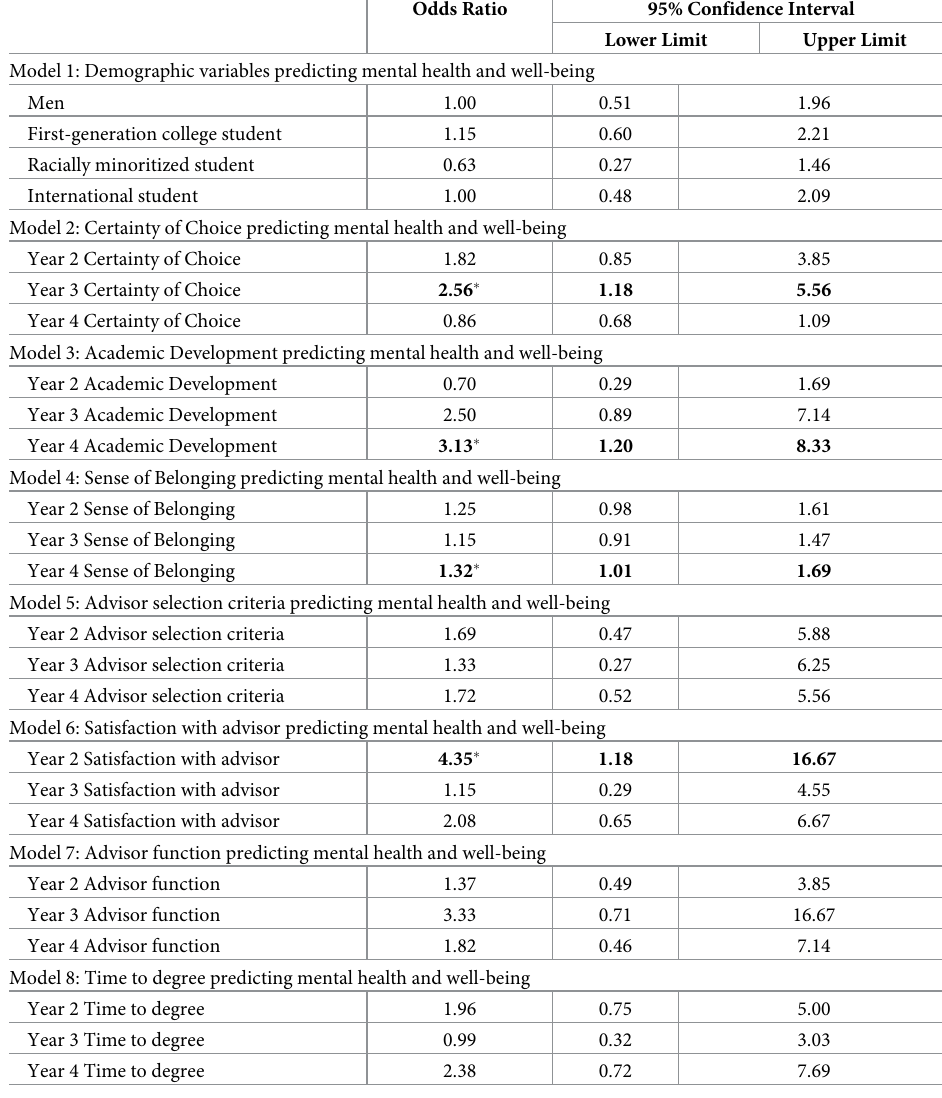
Model 8: Time to degree predicting mental health and